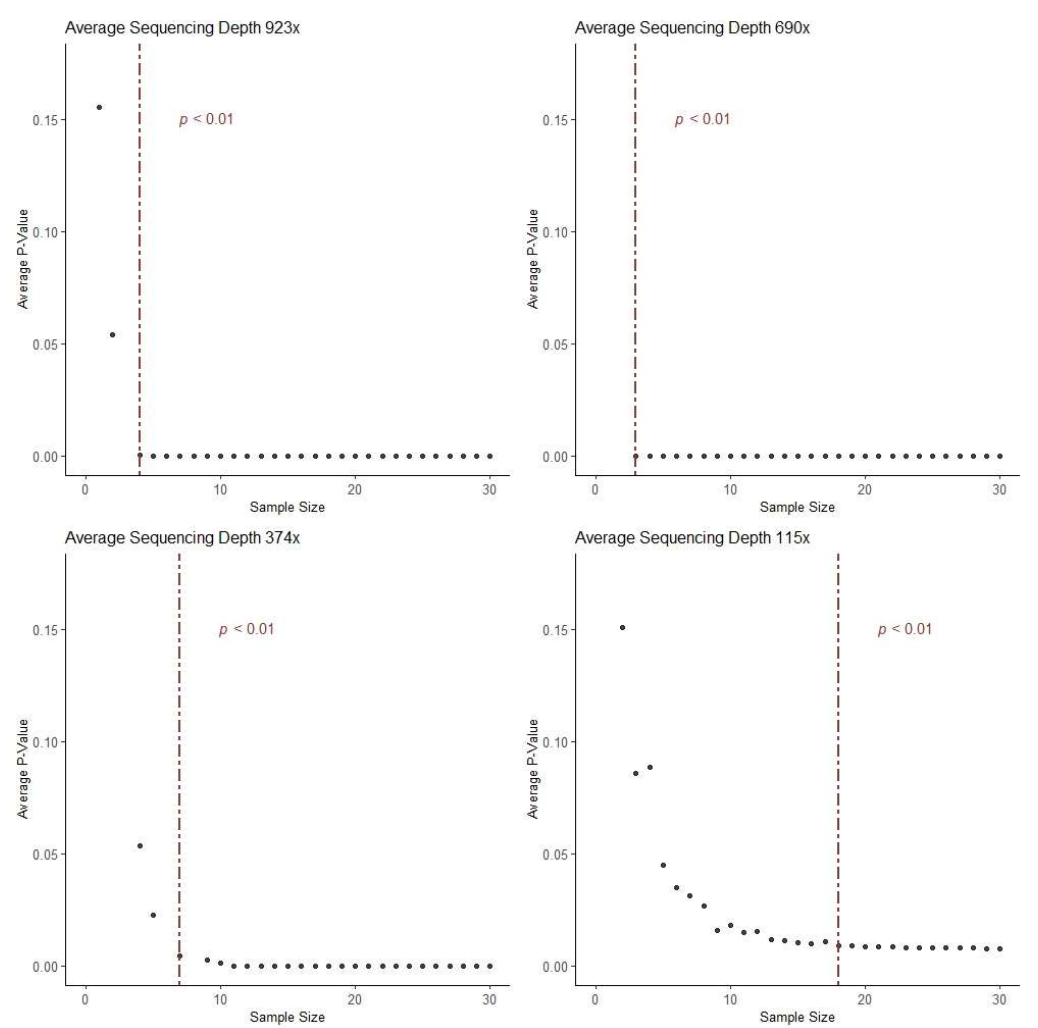
Figure 4. The optimal sample size for effective panel design based on varying sequencing depths 115 – 923×. Statistical significance was calculated using paired Wilcox signed-rank test. 115 – 923 × . Statistical significance was calculated using paired Wilcox signed-rank